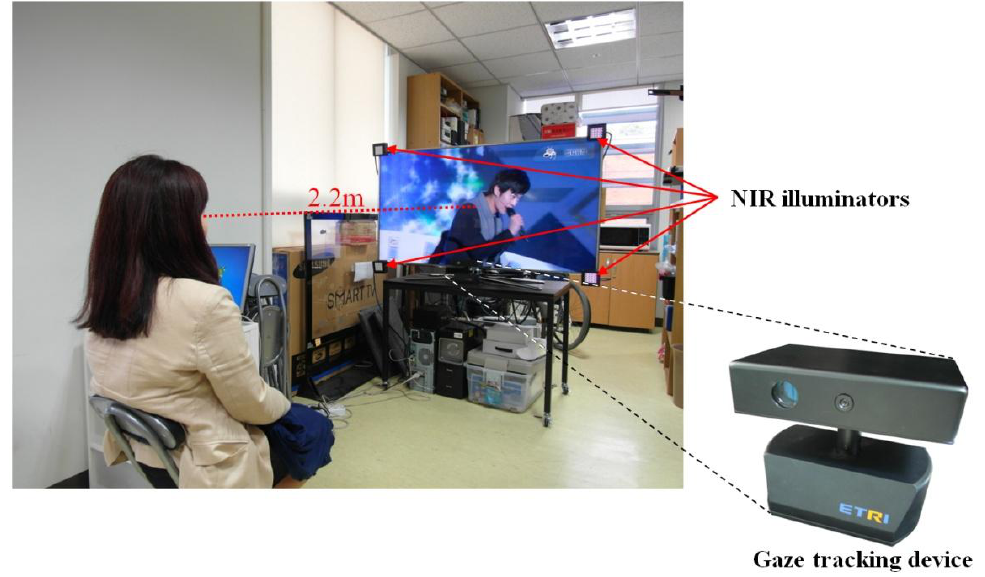
Figure 2. Example of using the proposed gaze tracking system with an intelligent TV.